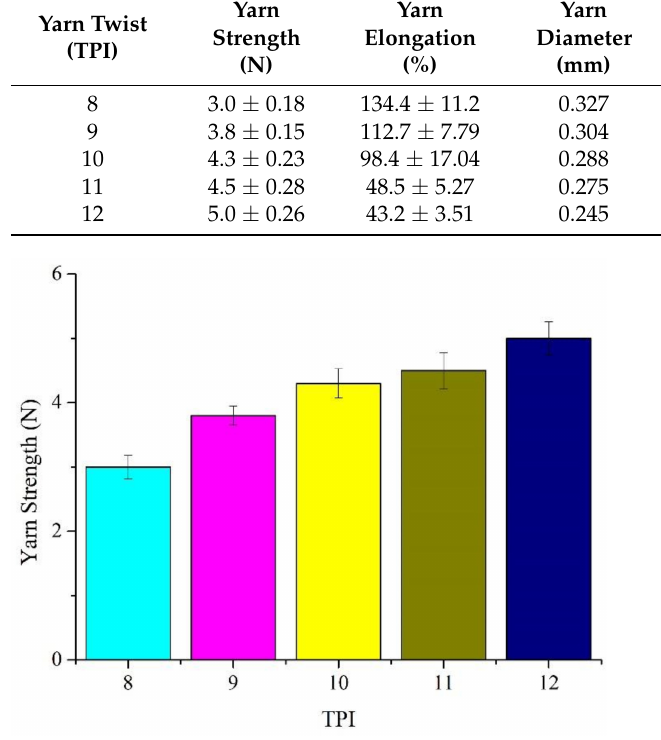
Figure 4. Tensile strength of the Ge/SS core-spun